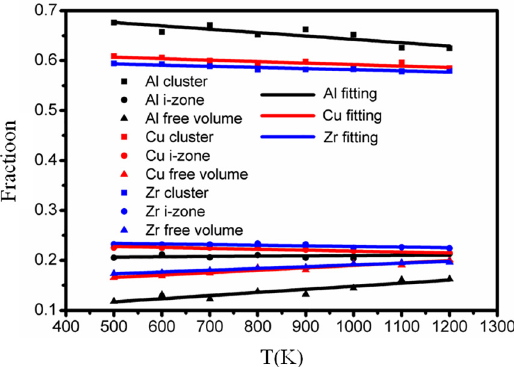
Figure 16. Changes of the relative fractions of Al, Cu and Zr cluster, i-zone and free volume atom pairs with temperature in AIMD simulations.